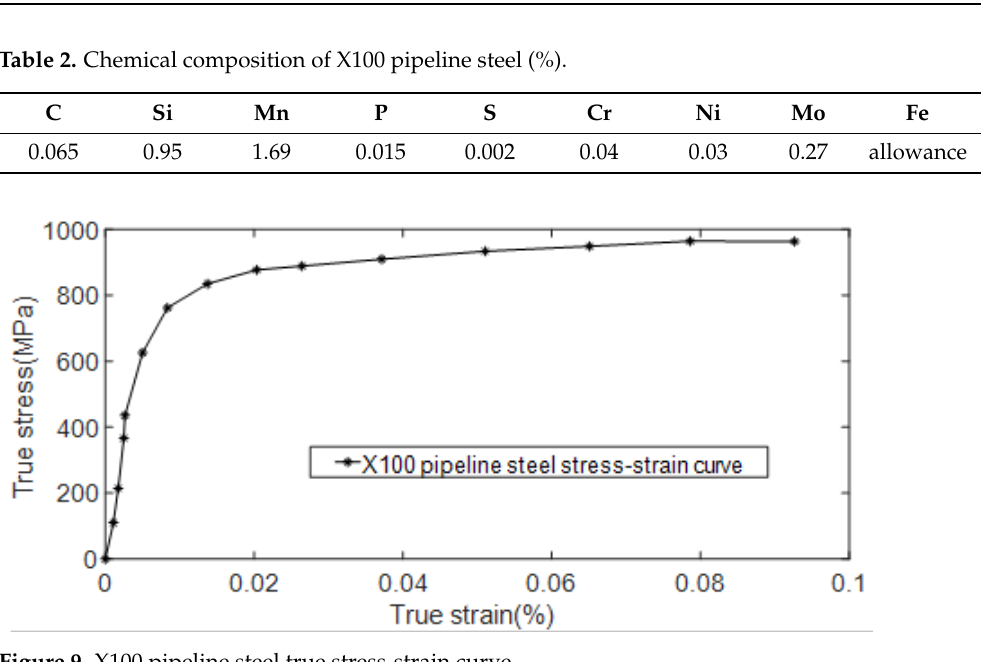
Table 2. Chemical composition of X100 pipeline steel (%).